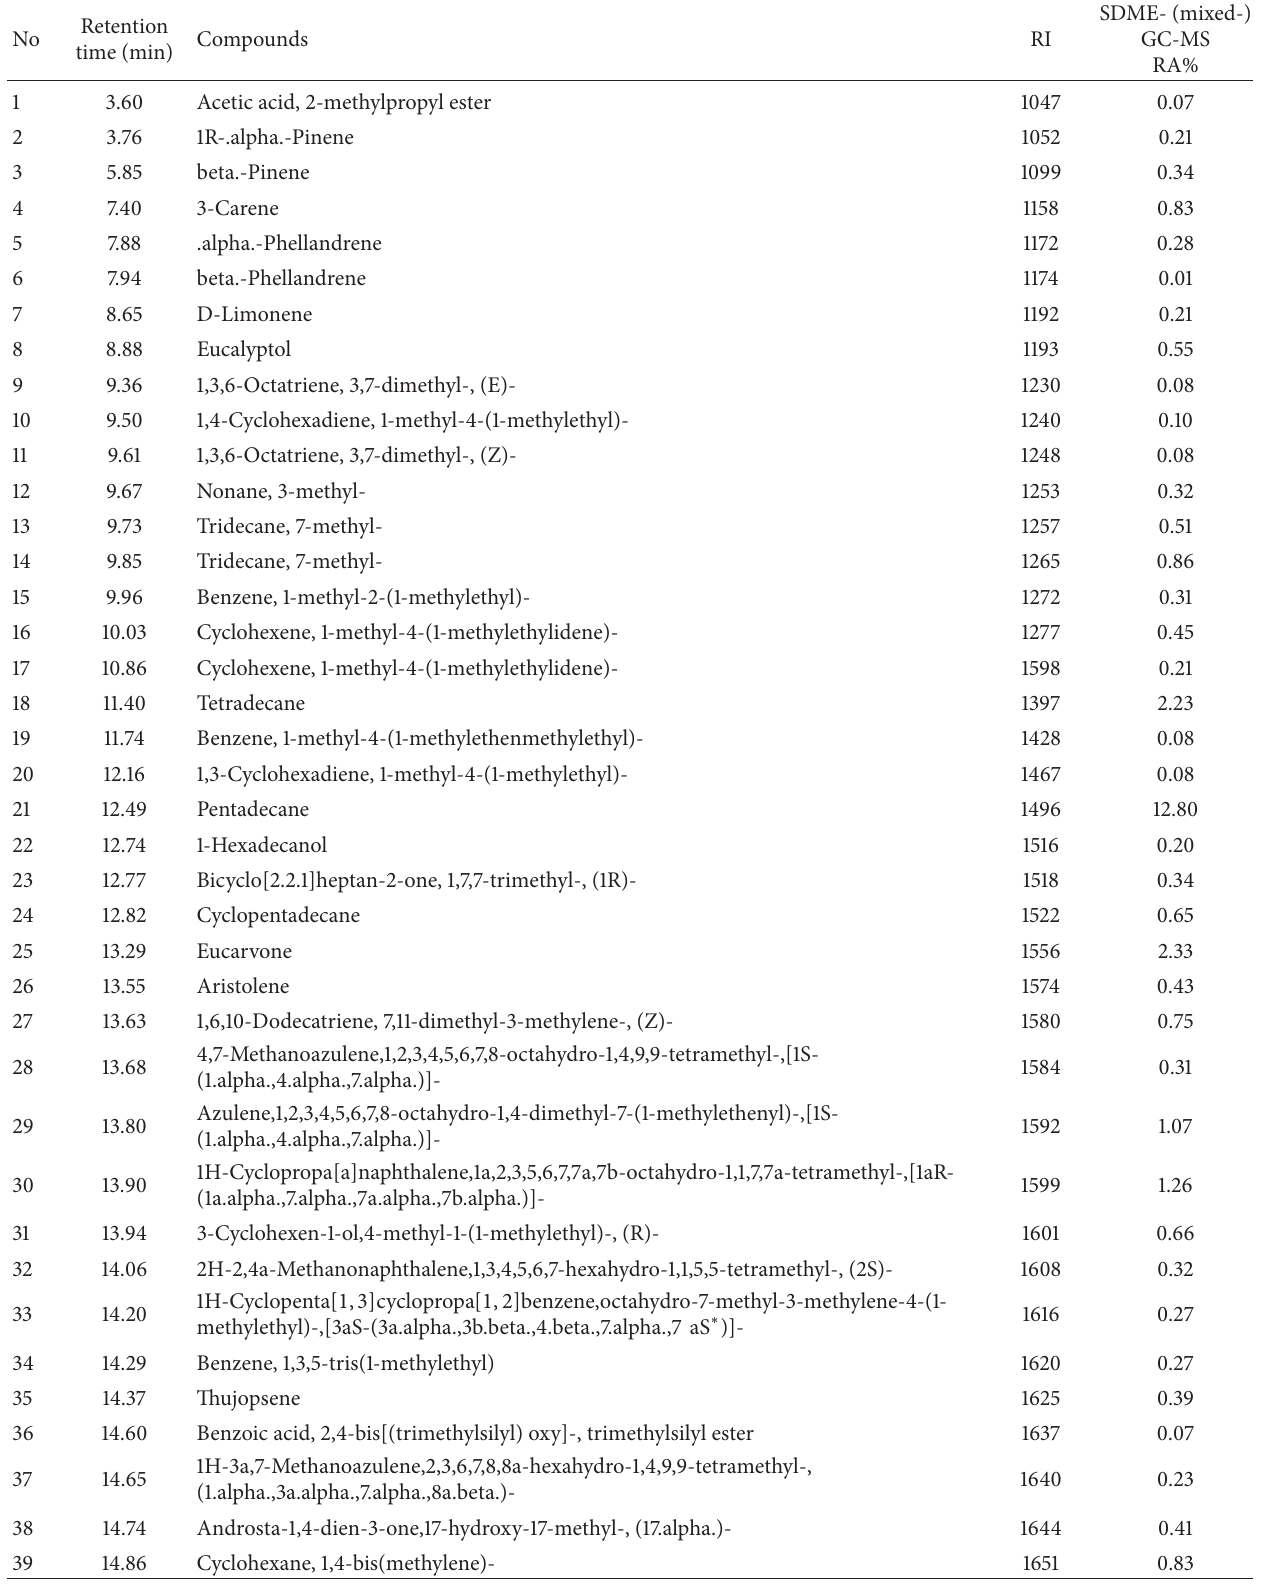
Table 1: Components of Herba Asari obtained by